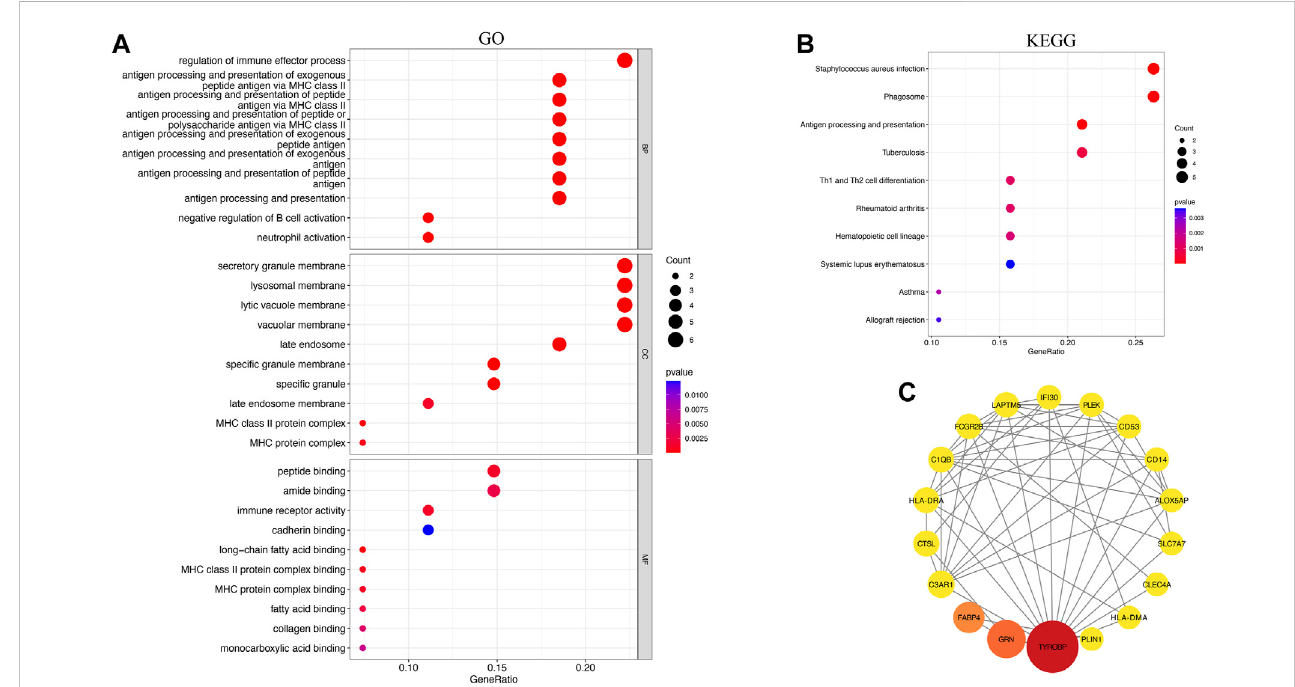
FIGURE 4 (A) Results of GO analysis of the top 10 common genes, including BP, MF and CC (B) Analysis of KEEG enrichment revealed signaling pathways strongly related with PVNS and RA. (C) PPI network constructed using the STRING database and Cytoscape. The wider the circle, the greater its signi fi cance, and the redder the color, the greater its signi fi cance.